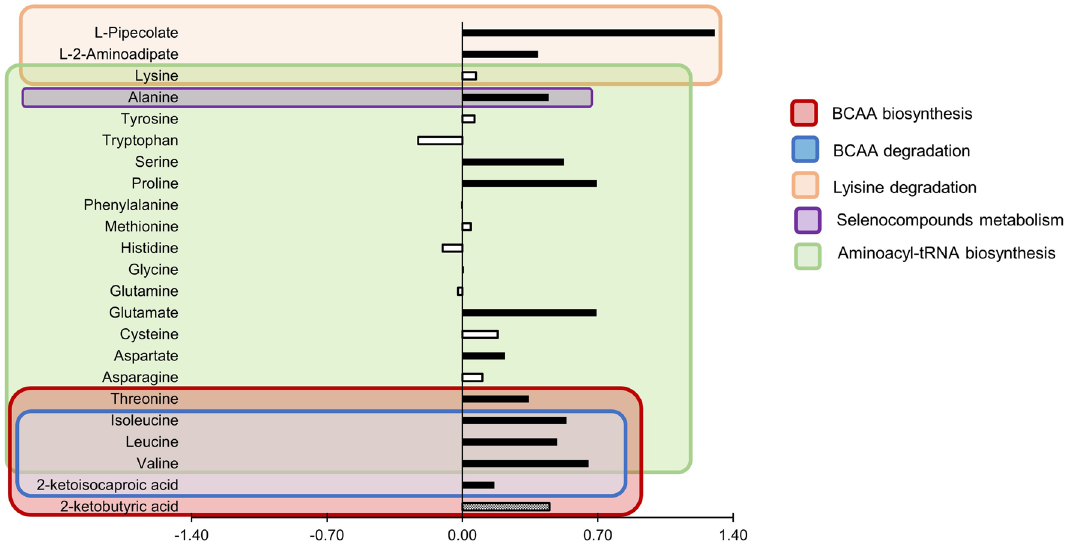
Figure 5. Log 2-fold change of quantified metabolites belonging to metabolic pathways identified to be differentially regulated (FDR < 0.10) between genetic strains (North American Holstein, NAH, n = 8; New Zealand Holstein, NZH, n = 8) NAH at 21 days in milk. Positive values mean greater concentrations in NAH relative to NZH cows. Black bars indicate P ≤ 0.05, gray bars are metabolites with 0.05 < P ≤ 0.10 and white bars indicate P > 0.10. Background colors indicate metabolic pathways indicated in the figure